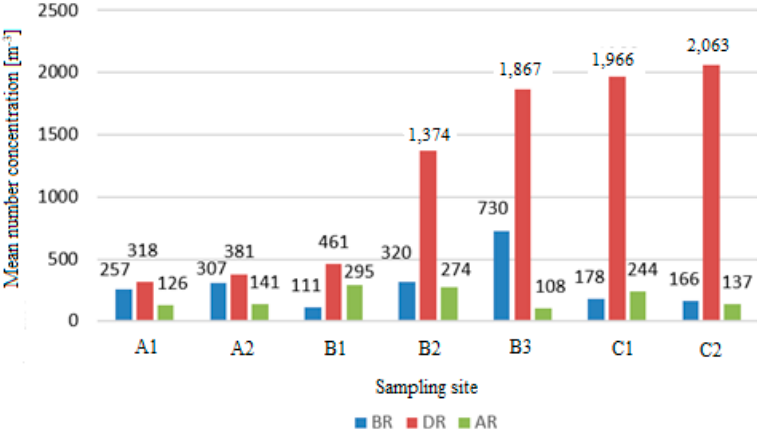
Figure 7. Mean number concentrations of asbestos on the sampling sites in the building before, during, and after removal of ACPs.